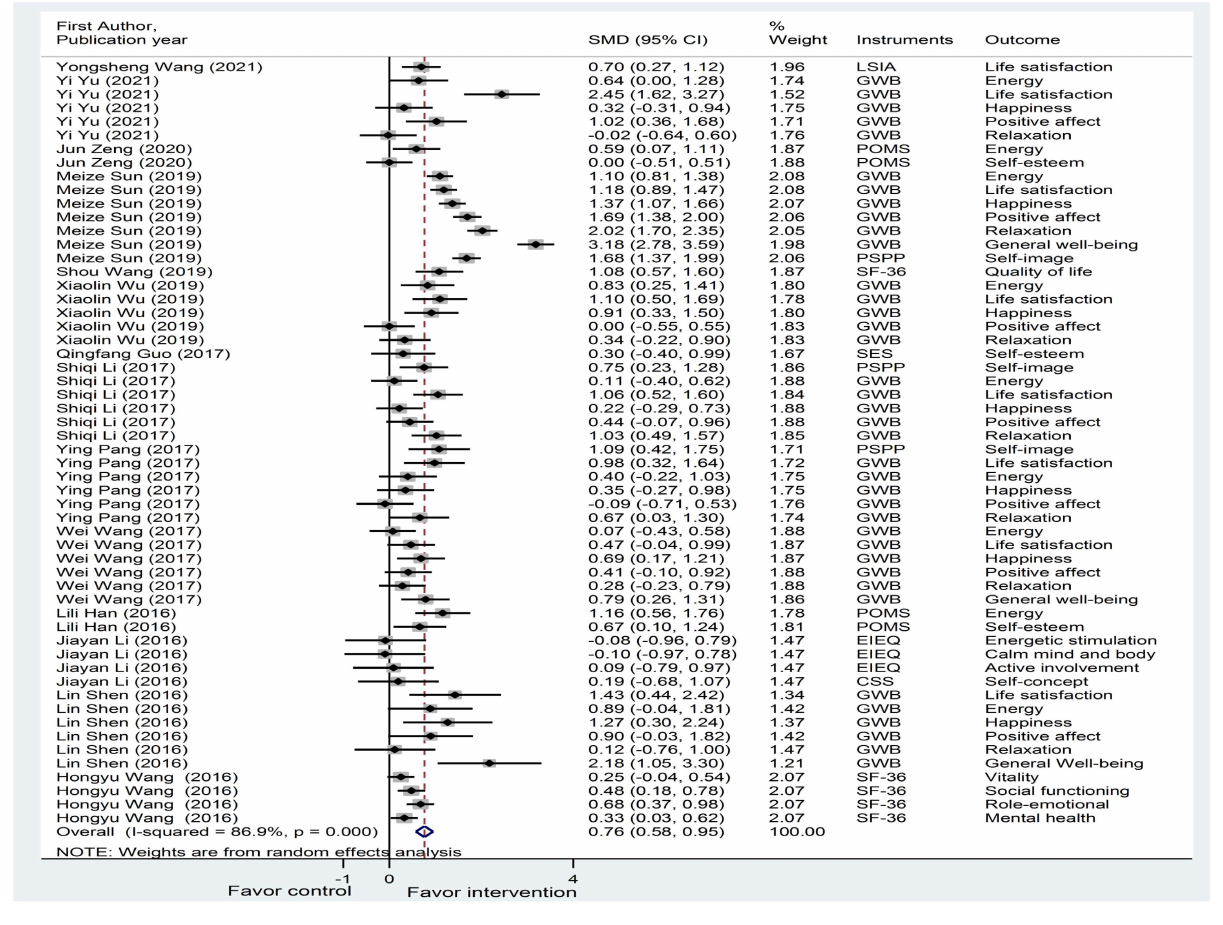
FIGURE 2 | A meta-analysis of the effectiveness of plaza dancing on psychological well-being. Seven studies reported results for psychological well-being, and seven studies reported results for both psychological well-being and ill-being. The results from 14 studies on psychological well-being (reporting 56 analyses, including different related outcomes) were included. The random-effects model was used as it assumes that varying effect sizes between the studies are due to the differences in the study content and population. Positive effect size values indicate higher scores for psychological well-being in favor of the intervention. BDI, Beck Depression Inventory; CSS, Core Self-Evaluation Scale; EIEQ, Exercise-Induced Emotion Questionnaire; GDS-15, 15-item Geriatric Depression Scale; GWB, General Well-Being Schedule; HAMA, Hamilton Anxiety Scale; HAMD, Hamilton Depression Scale; LSIA, Life Satisfaction Index A; PEES, Post-Exercise Emotional Experience Scale; POMS, Profile of Mood States; PSPP, Platform Sizing and Performance Program; SAS, Self-Rating Anxiety Scale; SCL-90, Symptom Check List 90; SDS, Self-Rating Depression Scale; SES, Self-Esteem Scale; SF-36, the MOS item short-form health survey; TMD, total of motional